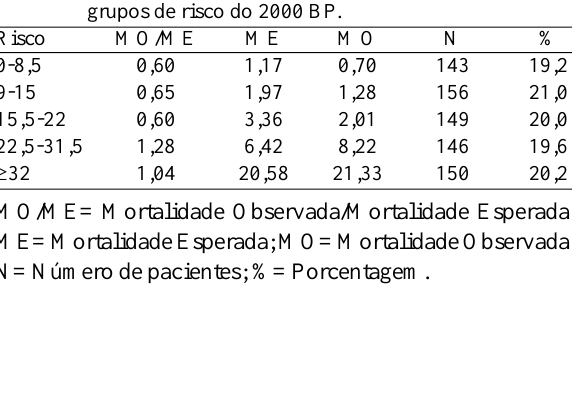
FE: Fração de ejeção; IAM: Infarto agudo do miocárdio; CIV: Comunicação interventricular; NC: não clarificado pelo 2000BP.